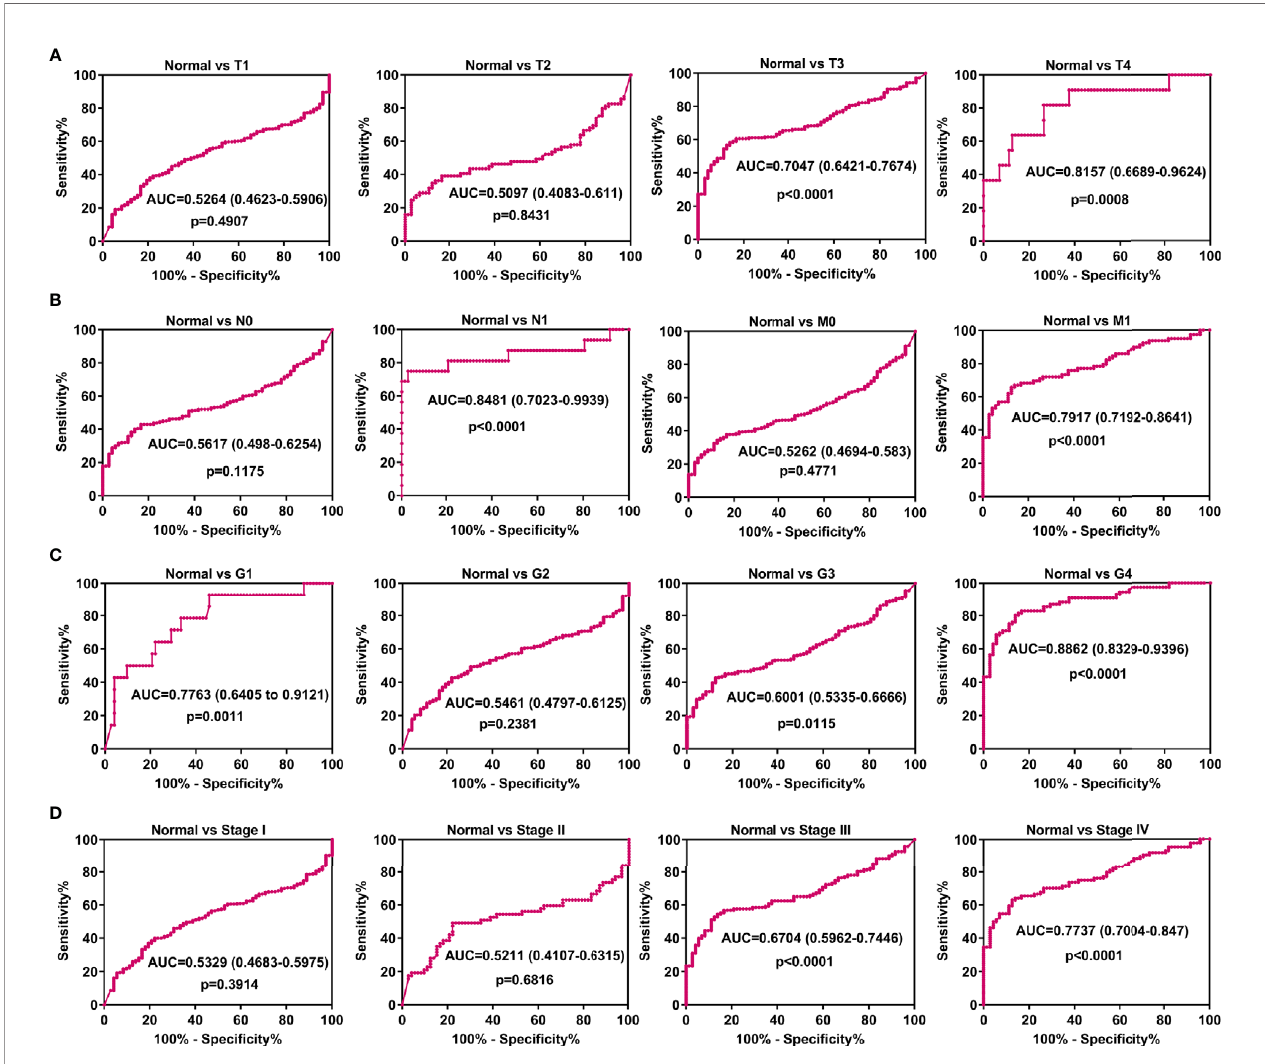
FIGURE 6 | Analysis of the diagnostic value of SAA1 for advanced and metastatic ccRCC. (A) ROC curve analysis of the diagnostic value of SAA1 in patients with ccRCC at T stage. (B) ROC curve analysis of the diagnostic value of SAA1 in patients with ccRCC at N and M stages. (C) ROC curve analysis of the diagnostic value of SAA1 in patients with ccRCC at tumor grade. (D) ROC curve analysis of the diagnostic value of SAA1 in patients with ccRCC at TNM